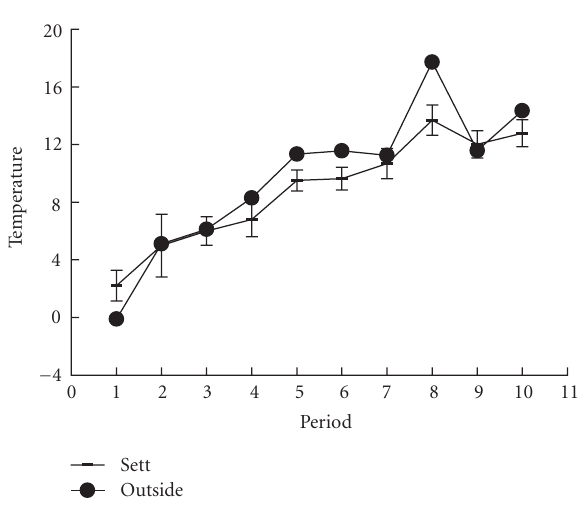
Figure 3: External (EAT) and internal (CIST) sett temperature change over ten periods between late February and early July 2004.